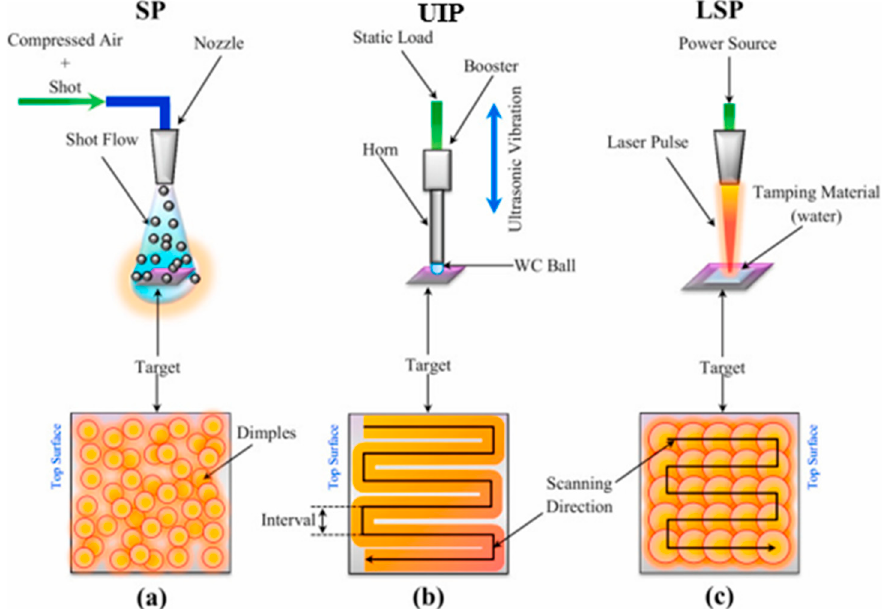
Figure 1. Schematic illustration of different peening techniques and the corresponding plastically deformed top surface of the target material: ( a ) SP; ( b ) UIP; ( c ) LSP. Reproduced with permission from [44]. Copyright Elsevier, 2021.